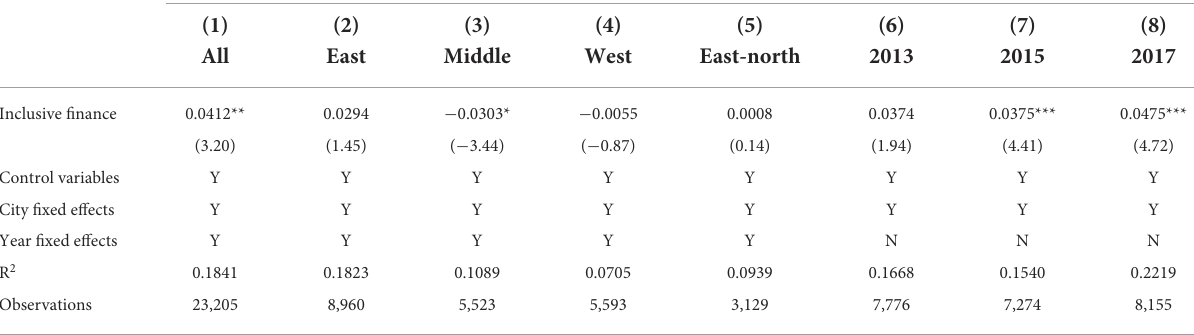
TABLE 4 Robustness test regression results.